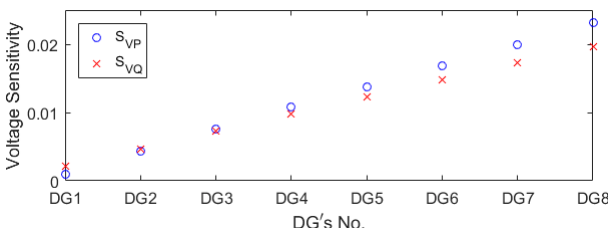
Figure 2. Voltage sensitivity at DG8 to active and reactive power variation.